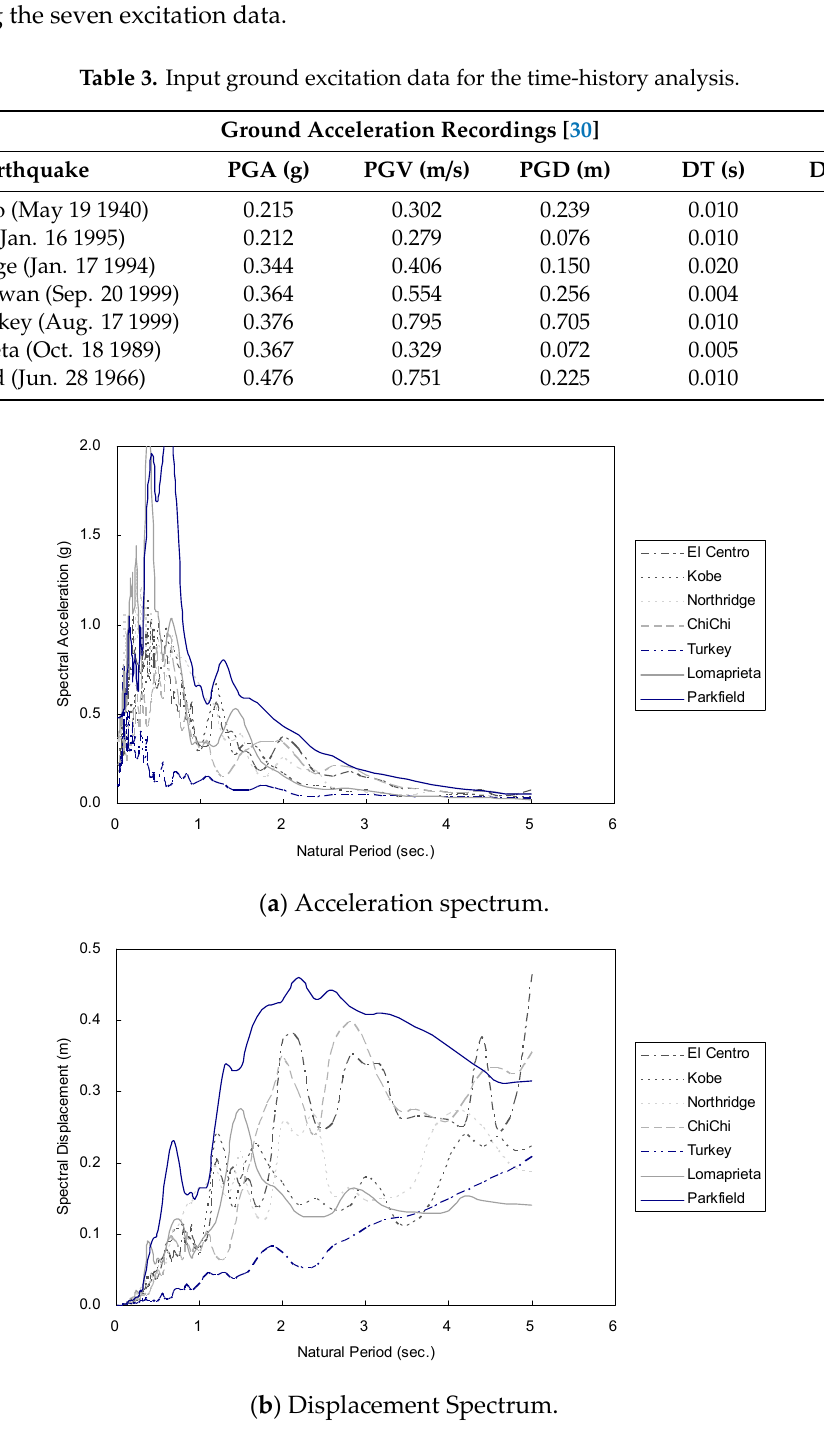
Figure 14. Spectral acceleration and displacement of the excitation data.